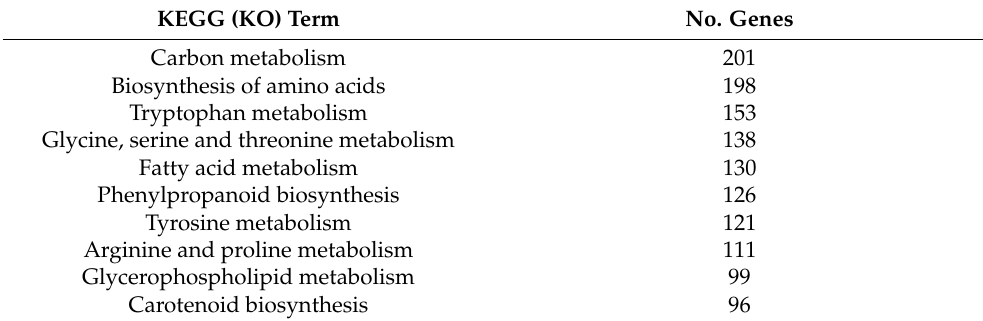
Table 3. Top 10 enriched KEGG pathways among the DEGs in the CgWT12h